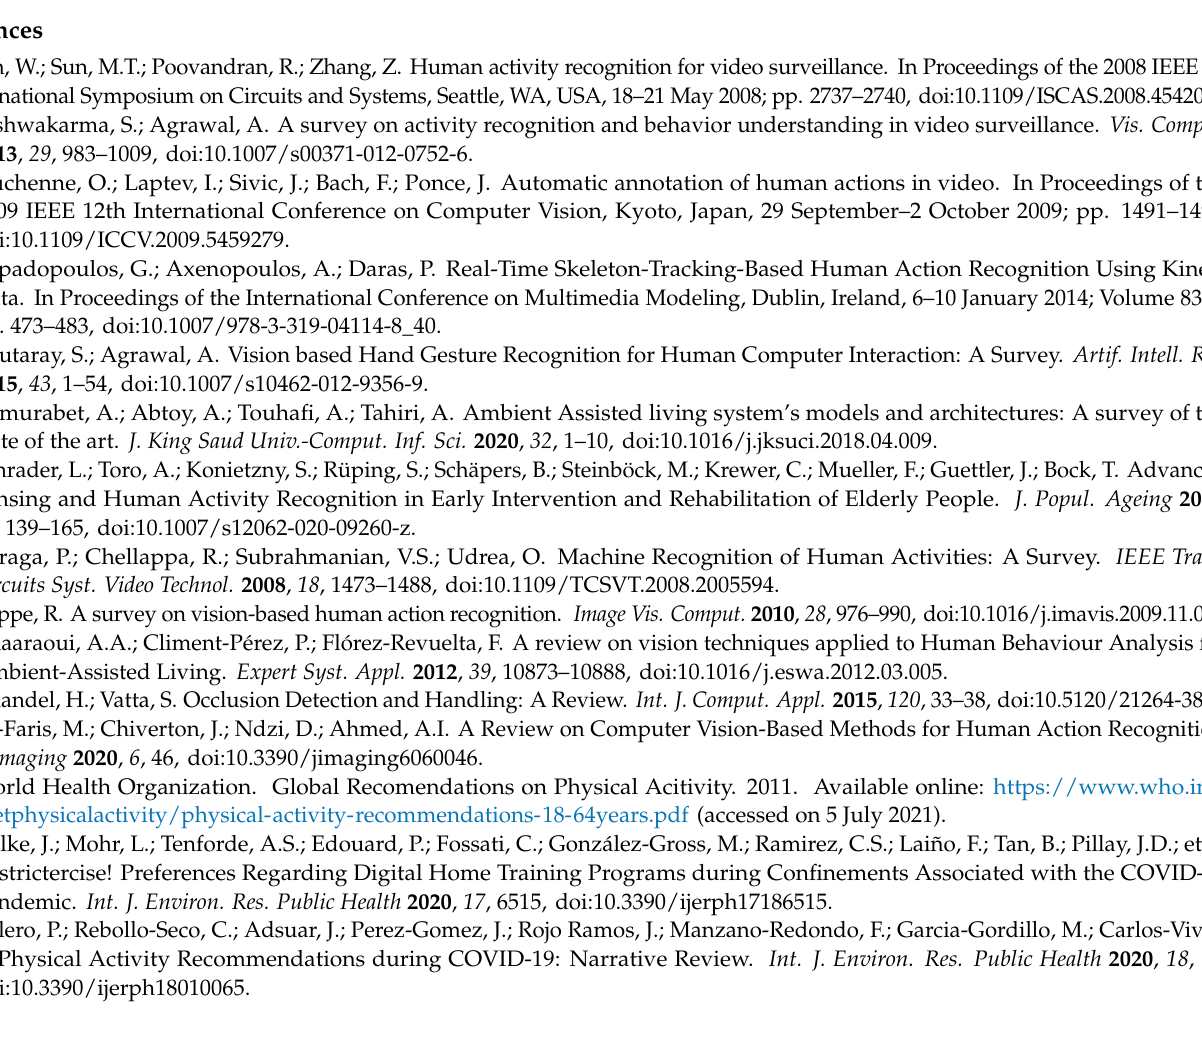
Figure A36. Confusion matrices for the experiment using the ‘upper-occlusion’ database, MBR perimeter and C1